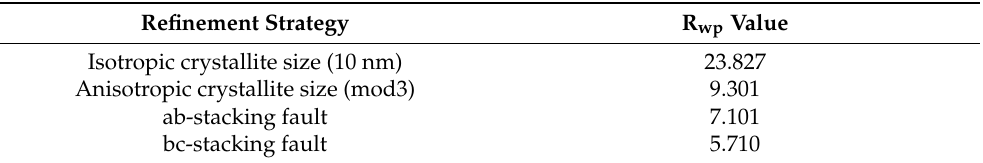
Table 5. Rwp-values of the final full profile fitting on the example of the sample catalyst C depending on the applied refinement